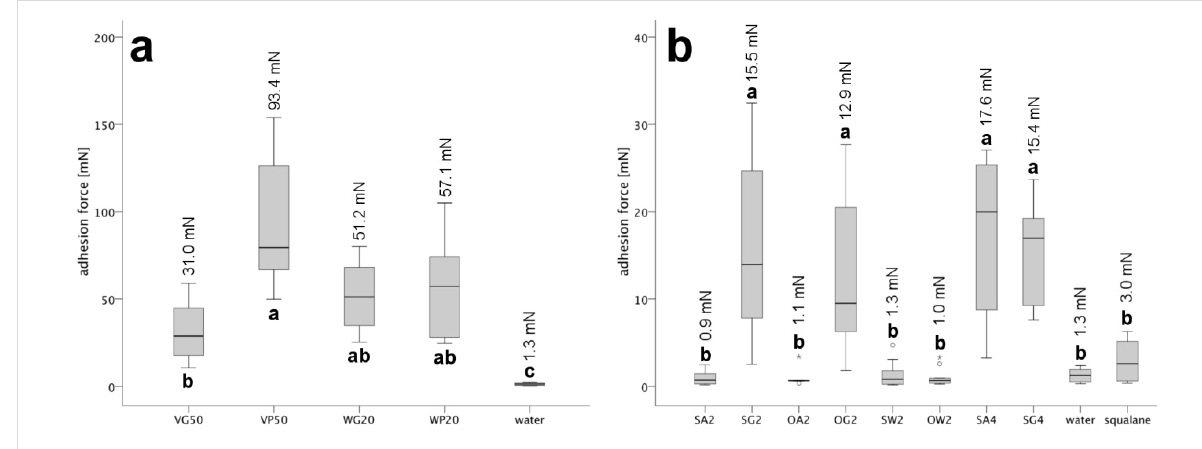
Figure 3: Box-plots of the adhesion forces of both generations of emulsions. The statistical comparison of the adhesion refers to the common loga- rithmized adhesion forces. Significant differences between the emulsion of logarithmized values (Supporting Information File 1, Tables S3 and S4) are indicated by different small letters (Kruskal–Wallis ANOVA followed by Kruskal–Wallis post hoc multiple comparisons). The measured values refer to a surface area of the silicium wafer of 6.45 mm 2 and a normal load of 3.3 mN. The value above each box depicts the arithmetic mean of its adhesion measurements as reported in Supporting Information File 1, Table S2. (a) Adhesion forces of the first generation (Supporting Information File 1, Table S2). All four emulsions show similar adhesion forces, whereby the combination of petrolatum and poly(vinyl alcohol) solution in VP50 generated the highest forces. (b) Adhesion forces of the second generation (Supporting Information File 1, Table S2). The addition of gelatin gives stronger adhe- sion forces in the emulsions SG2, OG2 and SG4. The asterisk and circles above and below the boxes categorize outliers (asterisk) and extreme values (circle). Outliers are defined as values showing a distance of 1.5–3 times of the box height from the box border (25% and 75% quantile), whereas the distance of extreme values is larger than 3 times the box